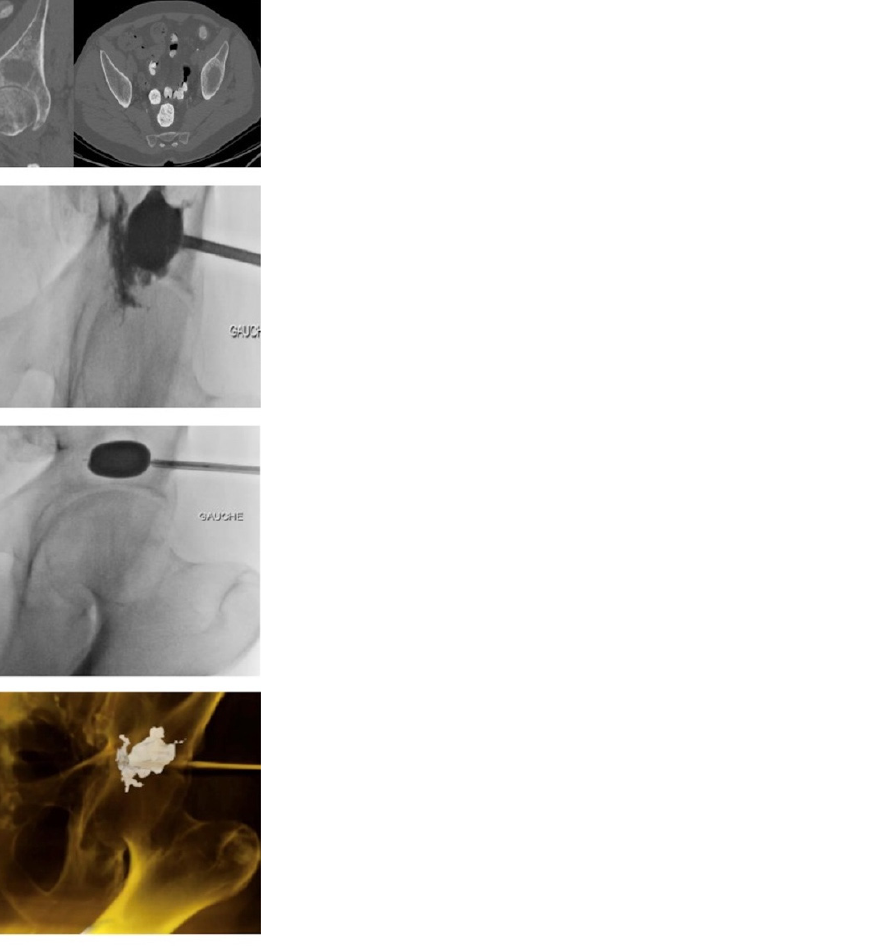
Figure 4. A patient with left superior acetabular metastatic lesion demonstrated on axial and coronal cuts of a preoperative computed tomography scan ( A ). The patient underwent balloon augmented cementoplasty ( B–D ). Images borrowed from Couraud et al. (2018) [17].